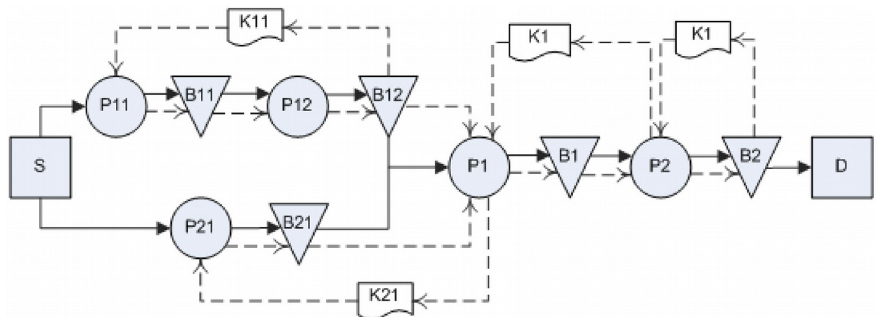
Figure 7. Conceptual mechanism of Hybrid3 (A5) system